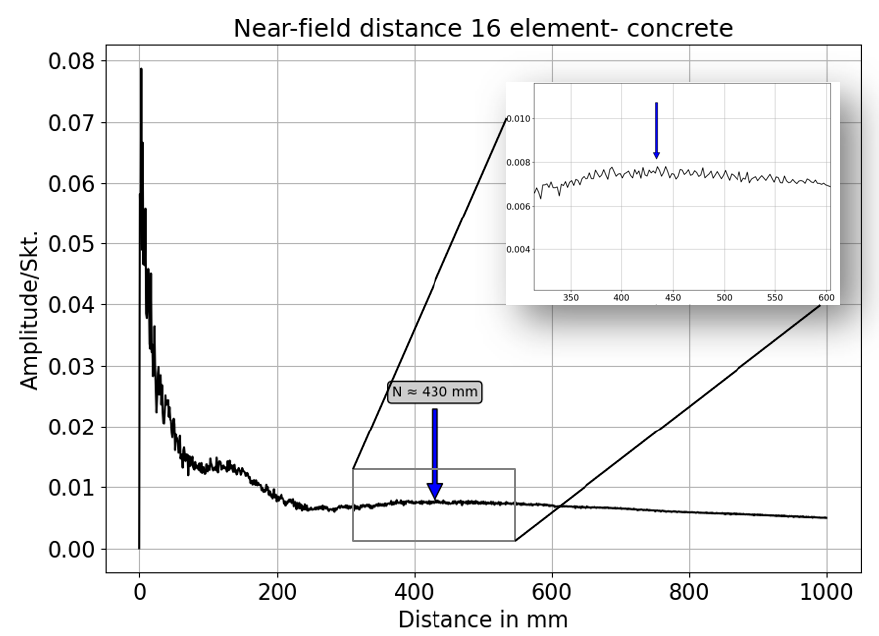
Figure 20. Simulated of near field distance for third generation borehole probe.